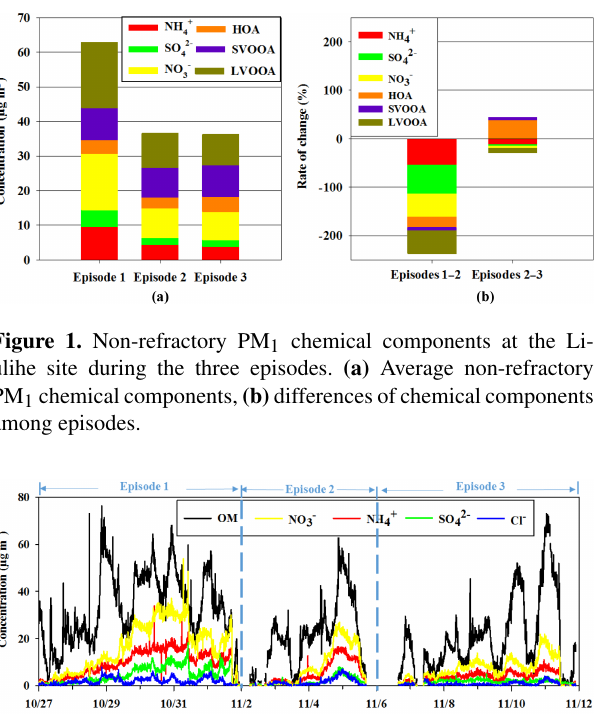
Figure 2. Temporal changes of non-refractory PM 1 chemical com- ponents at the Liulihe